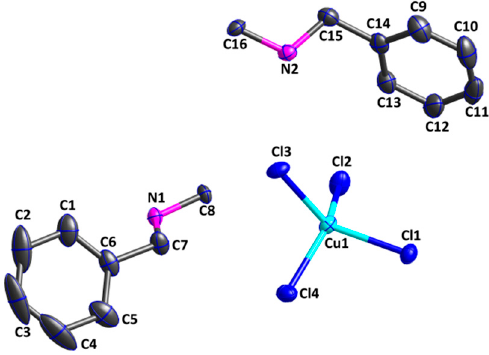
Figure 3. An asymmetric unit of compound ( 2 ) (thermal ellipsoids at 30% probability level).